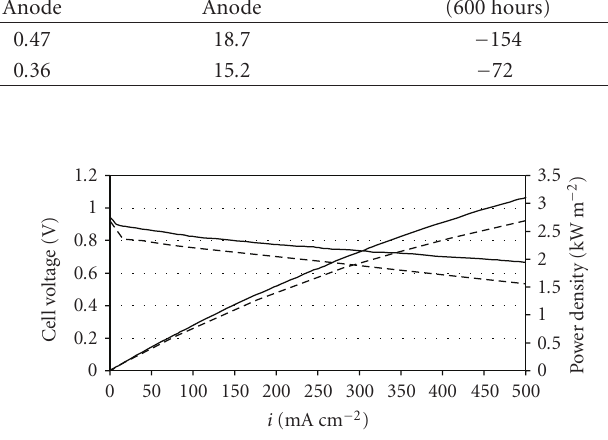
Figure 4: Cell voltage and power density versus current density plot for MEA with Nafion 112 (---) and Nafion/MMT (bold continuous lines) at 50 ◦ C in the early hours at low R.H.